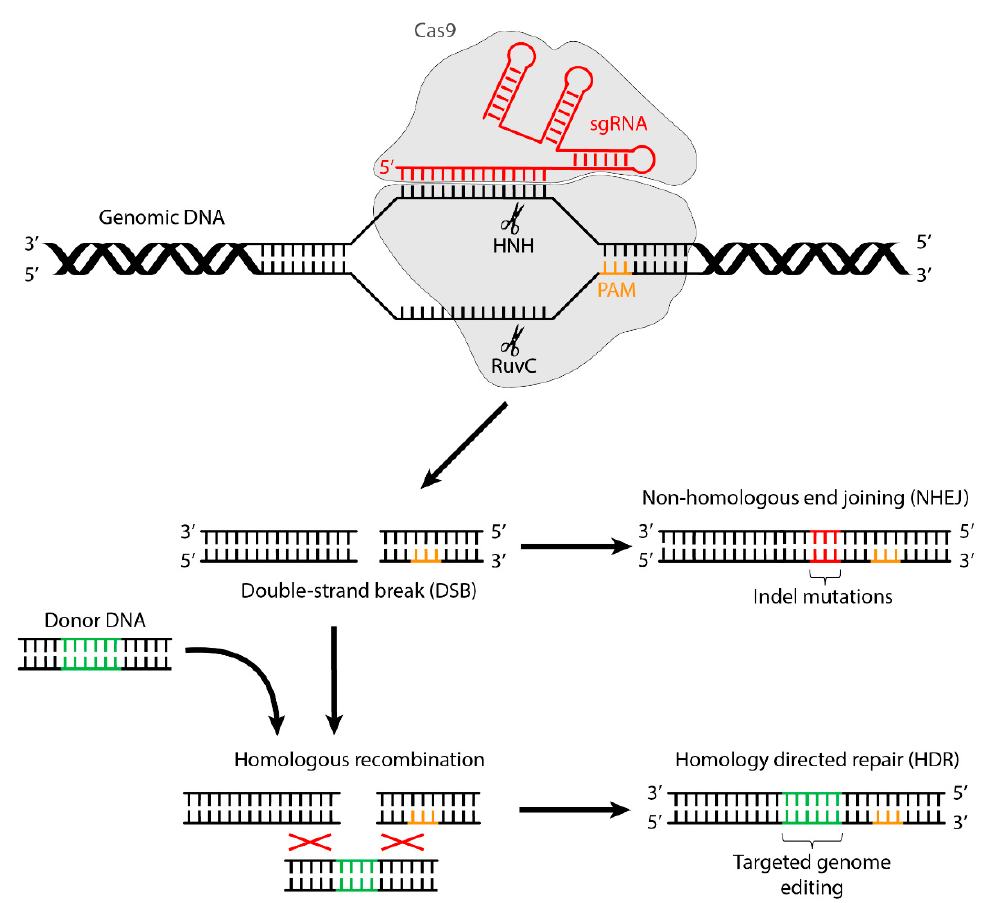
Figure 1. Mechanism of genome editing by CRISPR/Cas9.